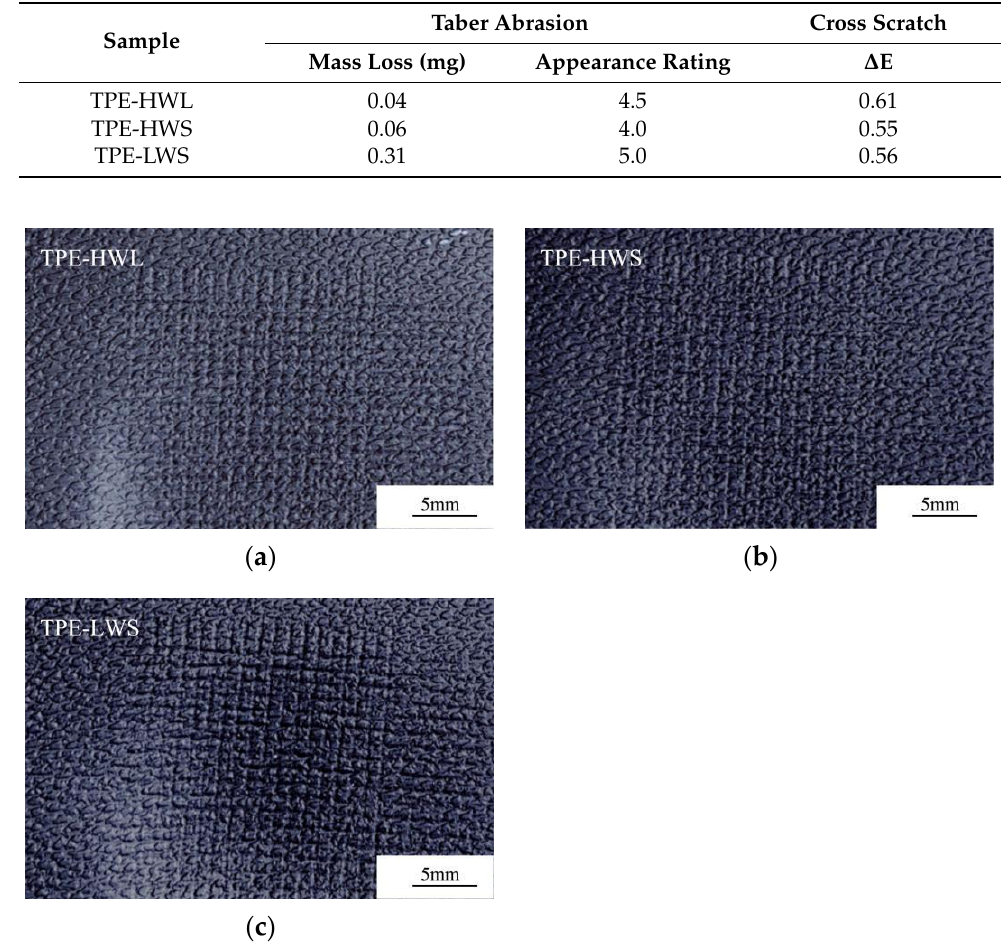
Figure 7. Cross scratching sample of TPE prepared by SEBS with various molecular structures.